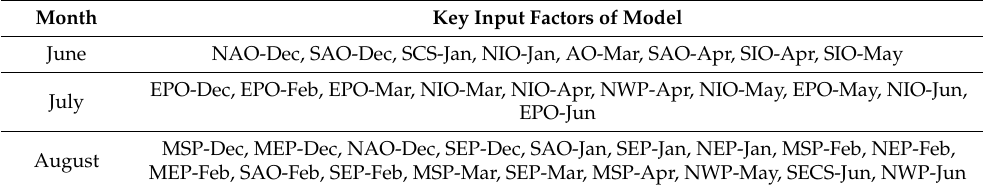
Table 1. Key input factors of RF model.